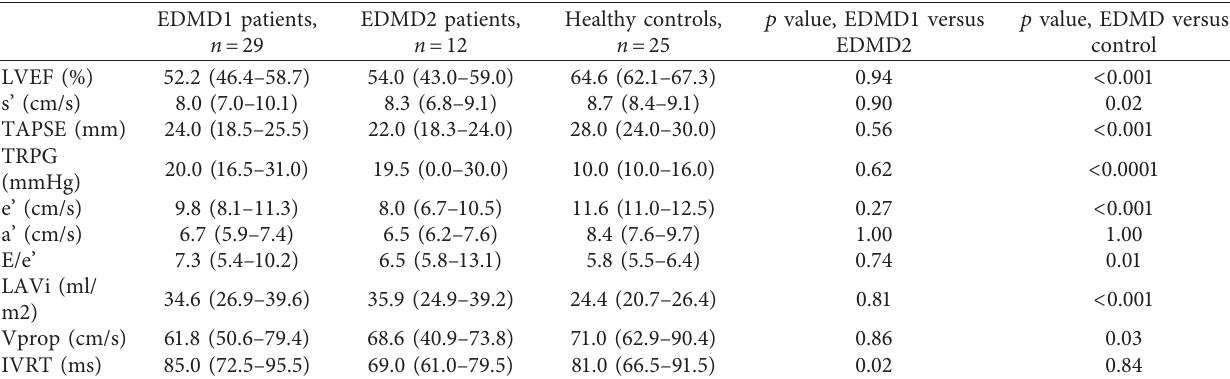
Table 3: Evaluation of systolic and diastolic function in EDMD and healthy controls.